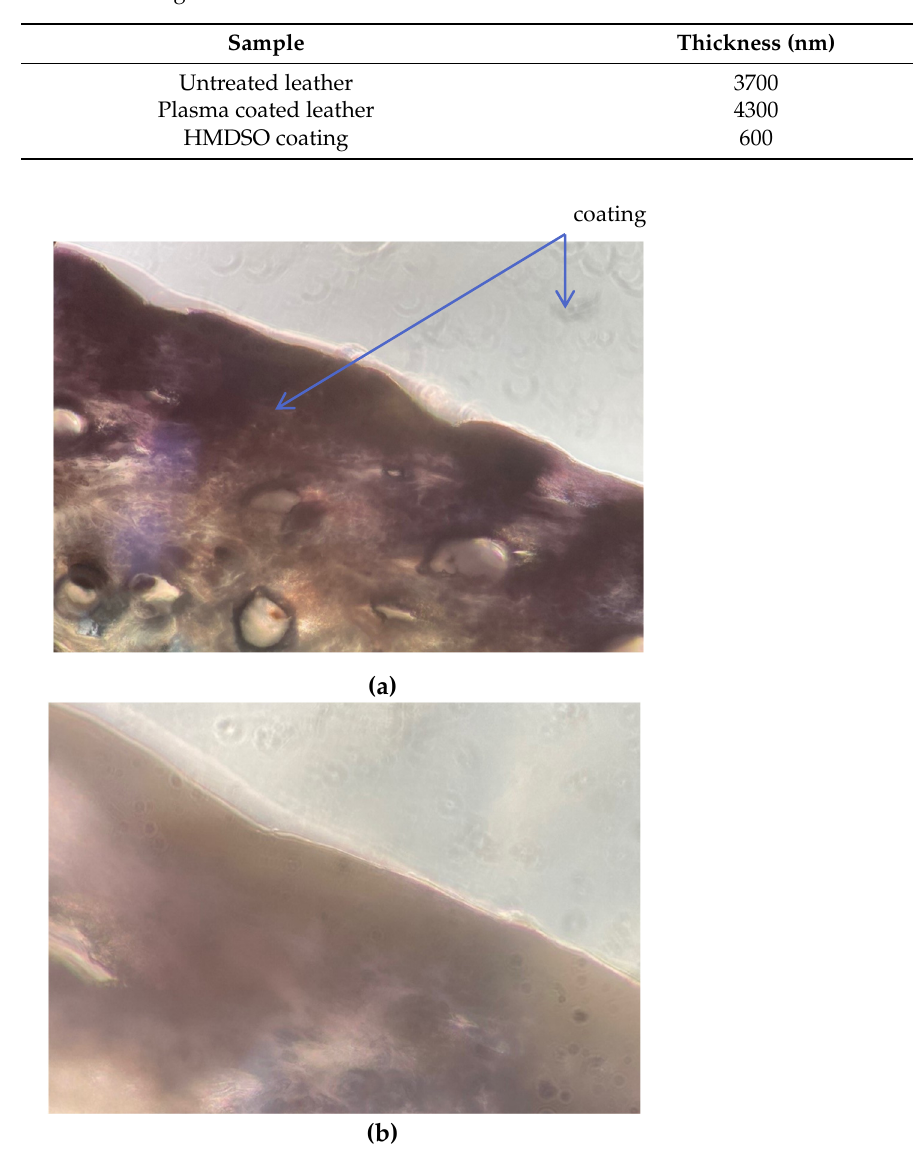
Table 7. Absorption time and contact angle in plasma treated and untreated leather samples.